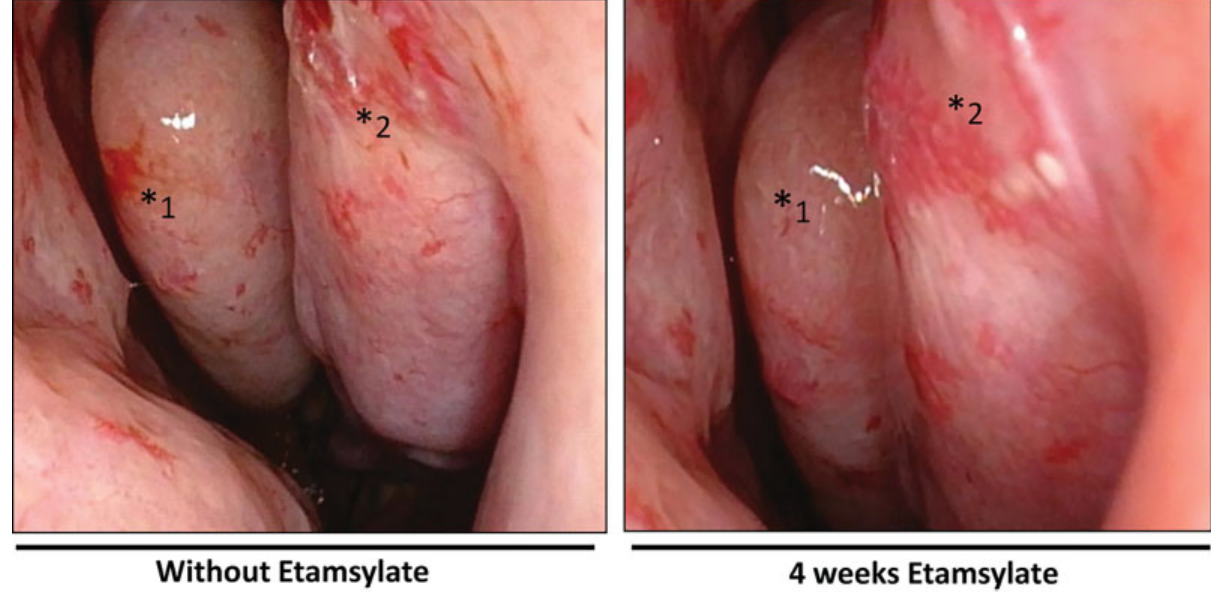
Fig. 8 The antiangiogenic effect of etamsylate on the nose mucosa. Aspect of the nose mucosa in a patient before starting the treatment, and around the same area after 4 weeks of treatment with etamsylate ( (cid:3) shows the major affected area).